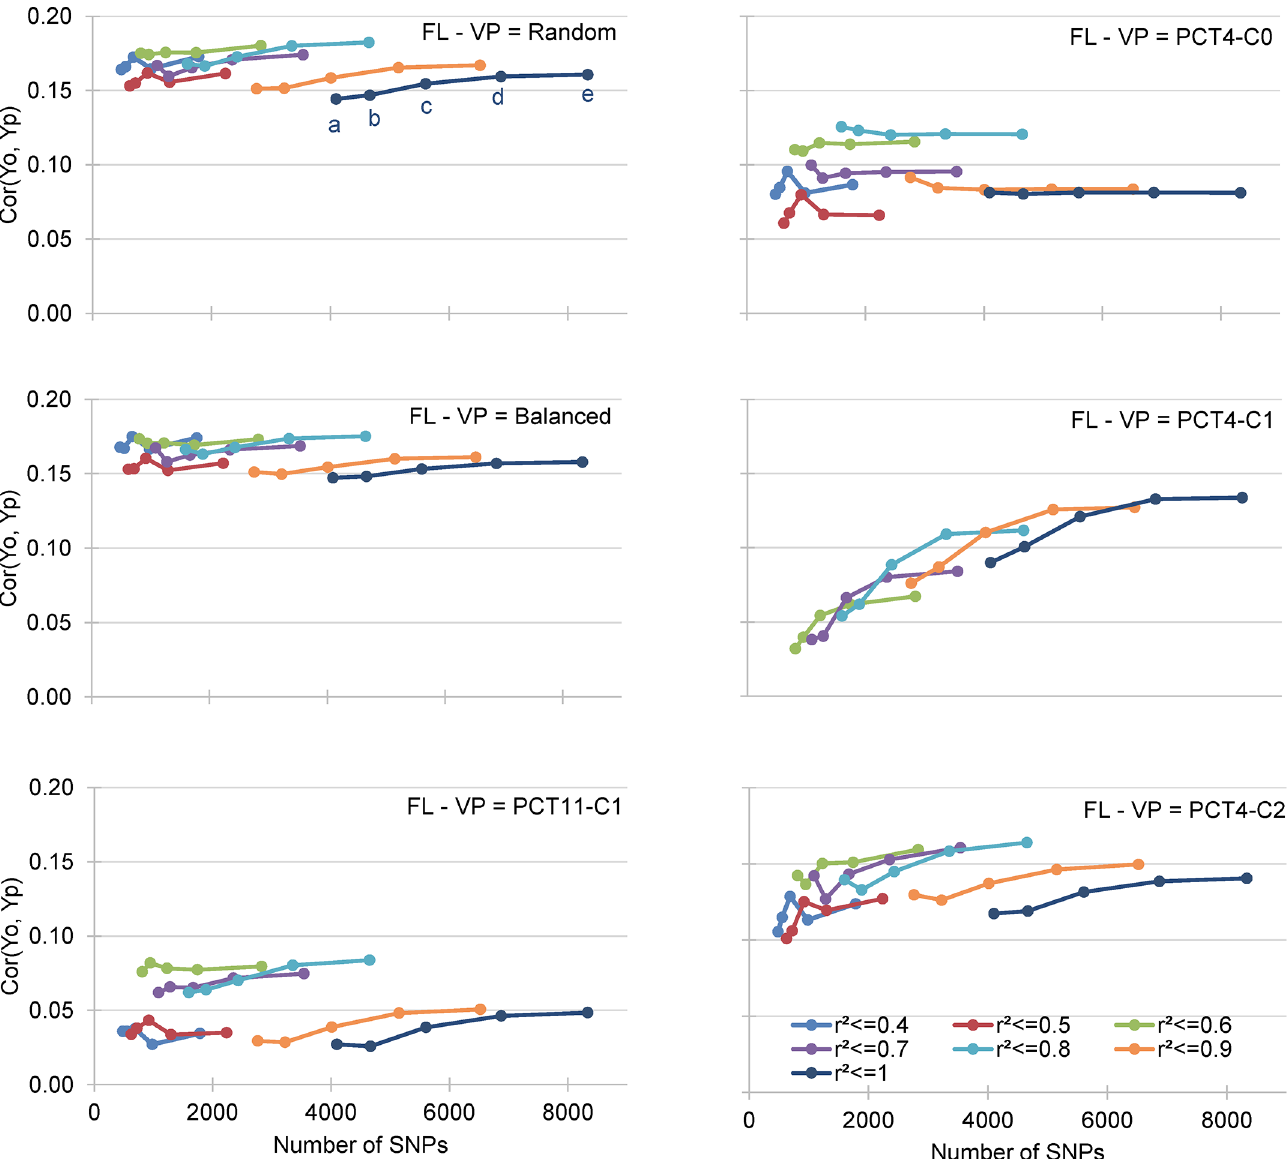
Fig 6. Mean correlation between GEBV obtained by cross validation of the training data set (Yp) and the observed BLUP values of the validation data sets (Yo). Results for day to flowering (FL) are presented for different composition of the validation population